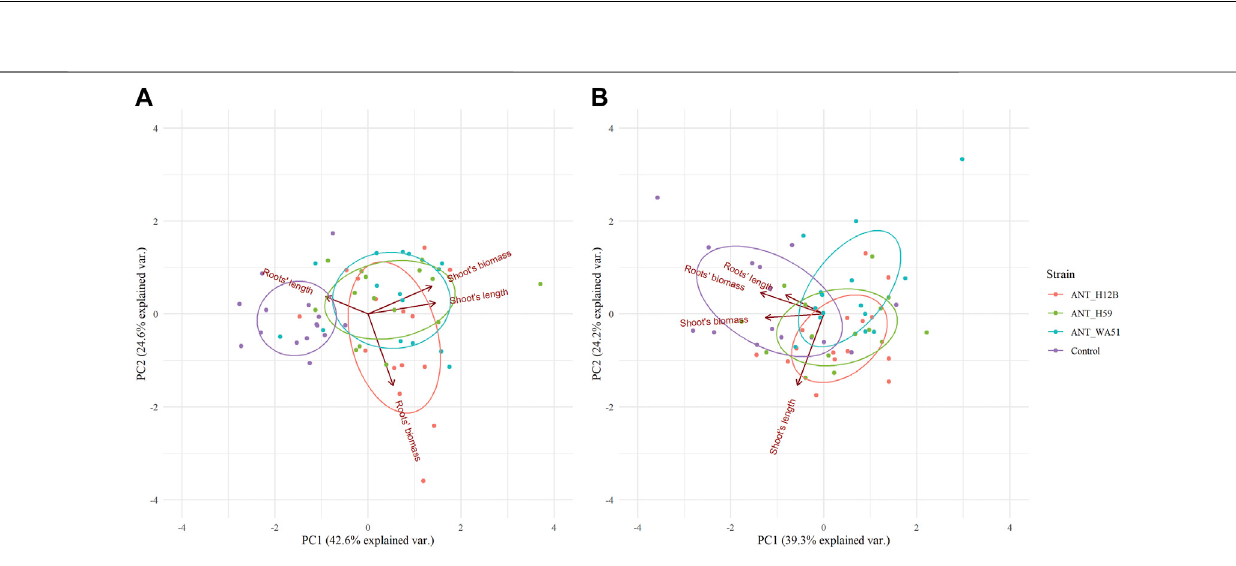
Frontiers in Bioengineering and Biotechnology |